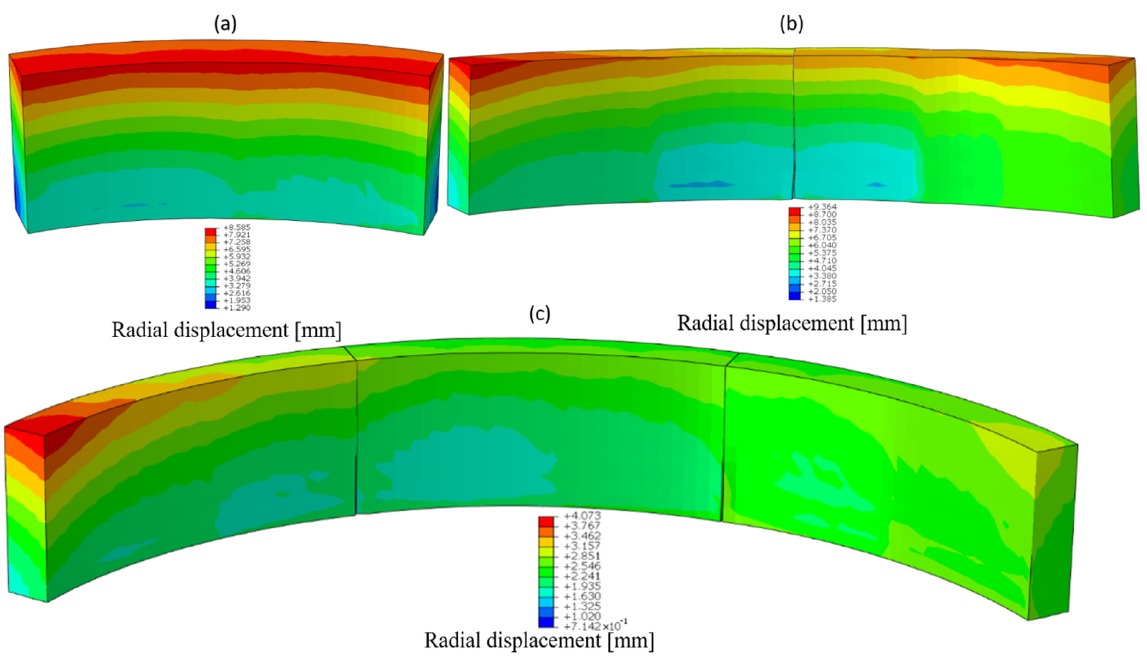
Figure 11. The interaction between the segments when the segments are lateral: ( a ) first segment assembly; ( b ) second segment assembly; ( c ) third segment assembly.